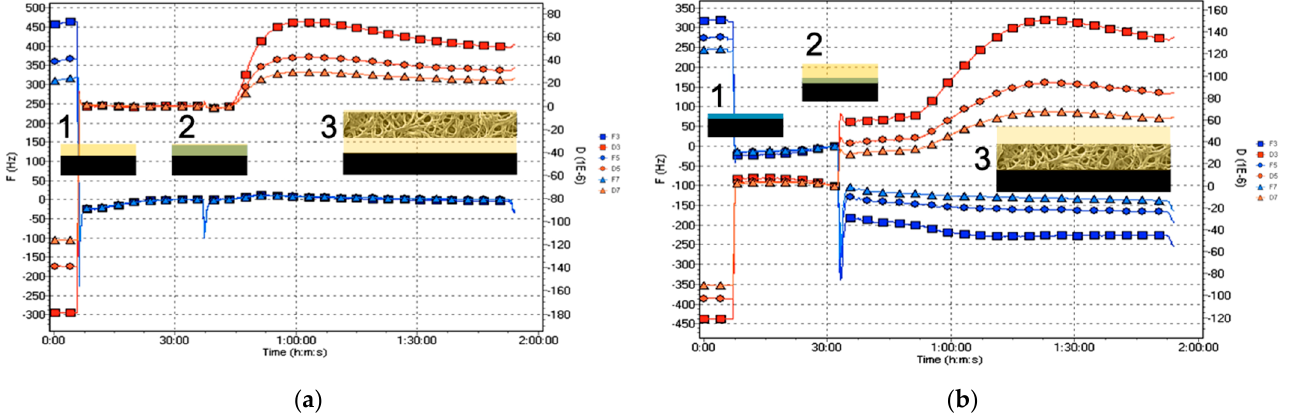
Figure 2. Evolution of the third, fifth, and seventh overtones of frequency (F, blue) and dissipation (D, red) of the samples ( a ) NoCa (Plasma first) and ( b ) Ca (Ca first) according to the different modifications described in Figure 1: the frequency and dissipation changes at points 1–3 are shown in Table 1. #1 Surfaces (a) unmodified (NoCa), or (b) modified with calcium ions (Ca) prior to any subsequent addition (contact with air). #2 Plasma deposition (without Ca in b). #3 Coagulation.